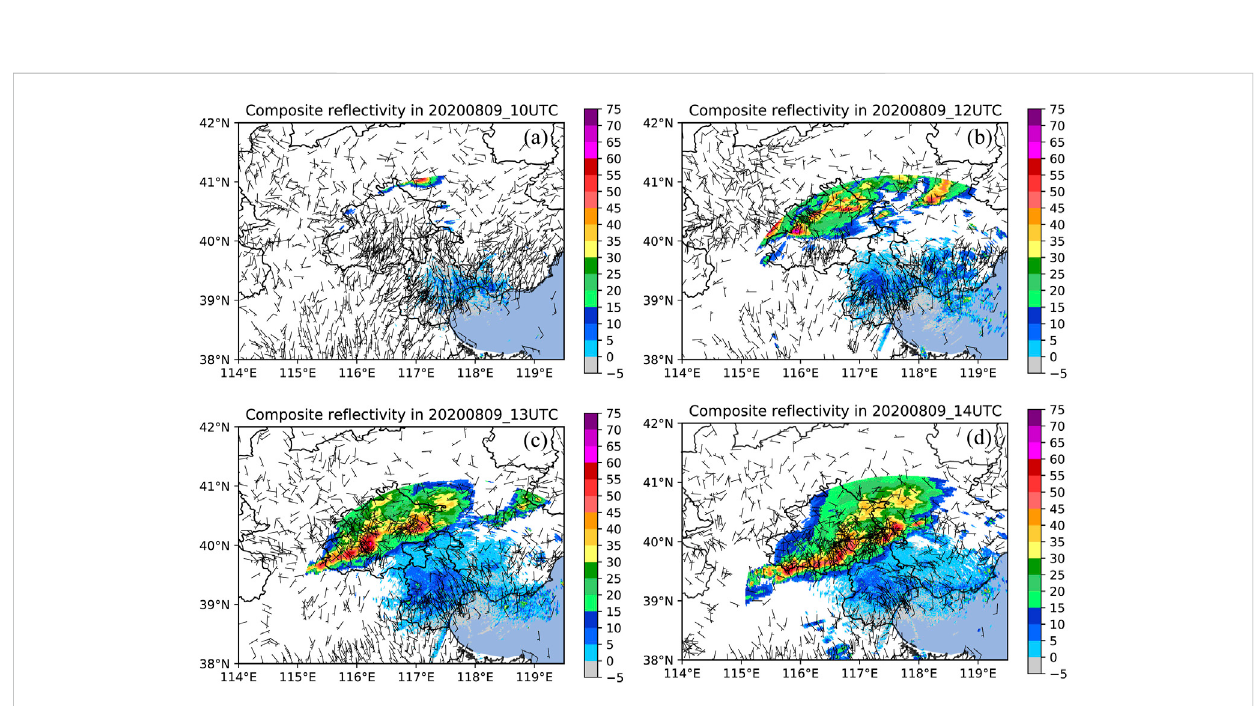
FIGURE 4 The surface observed composite radar re fl ectivity (shaded; dBZ) superimposed 10-m wind fi elds (vectors; m s − 1 ) from automated surface observation stations at (A) 1000 UTC, (B) 1200 UTC, (C) 1300 UTC and (D) 1400 UTC on 9 August 2020,